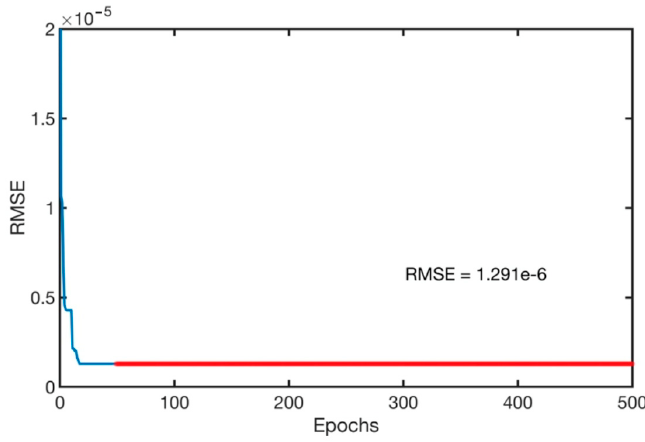
Figure 10. Training epochs vs. RMSE for the cryogenic turning process.